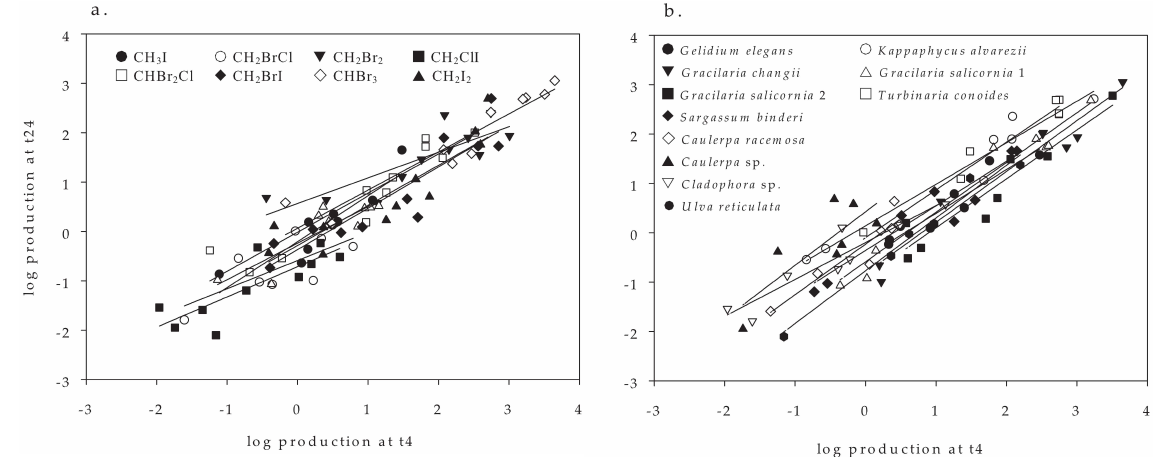
Fig. 2. Correlation between log-normalised production (pmolgFW − 1 h − 1 ) at t 4 and t 24 for (a) individual halocarbons and (b) seaweed